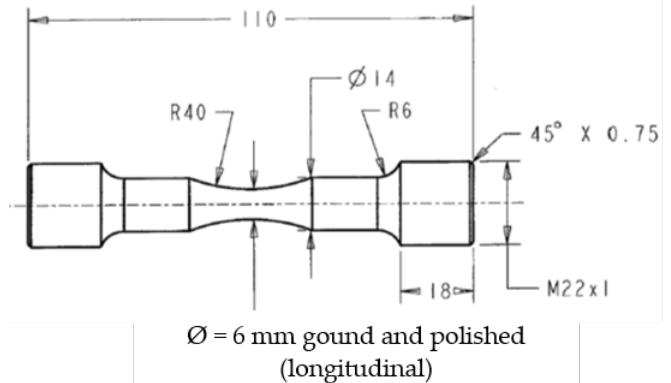
Figure 2. Drawing of the sample geometry.